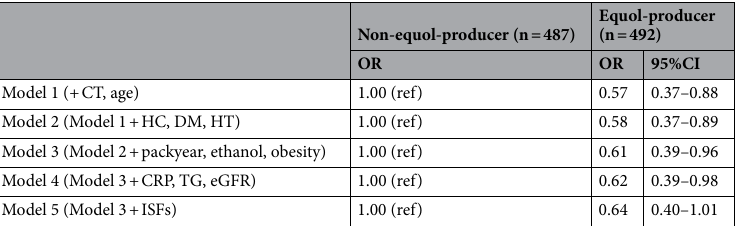
Table 2. The OR (95%CI) of aortic calcification presence for equol-producer vs. non- equol-producer (n = 979). OR, odds ratio; CI, confidence interval; HT, hypertension; DM, diabetes; HC, hypercholesterolemia; eGFR, estimated glomerular filtration rate; TG, triglycerides; CRP, C-reactive protein; ISF, isoflavones. ISFs = creatine-adjusted urinary levels of daidzein + genistein. The R-square values for the models are: model 1, 0.51; model 2, 0.59; model 3, 0.62; model 4, 0.63; model 5, 0.63.